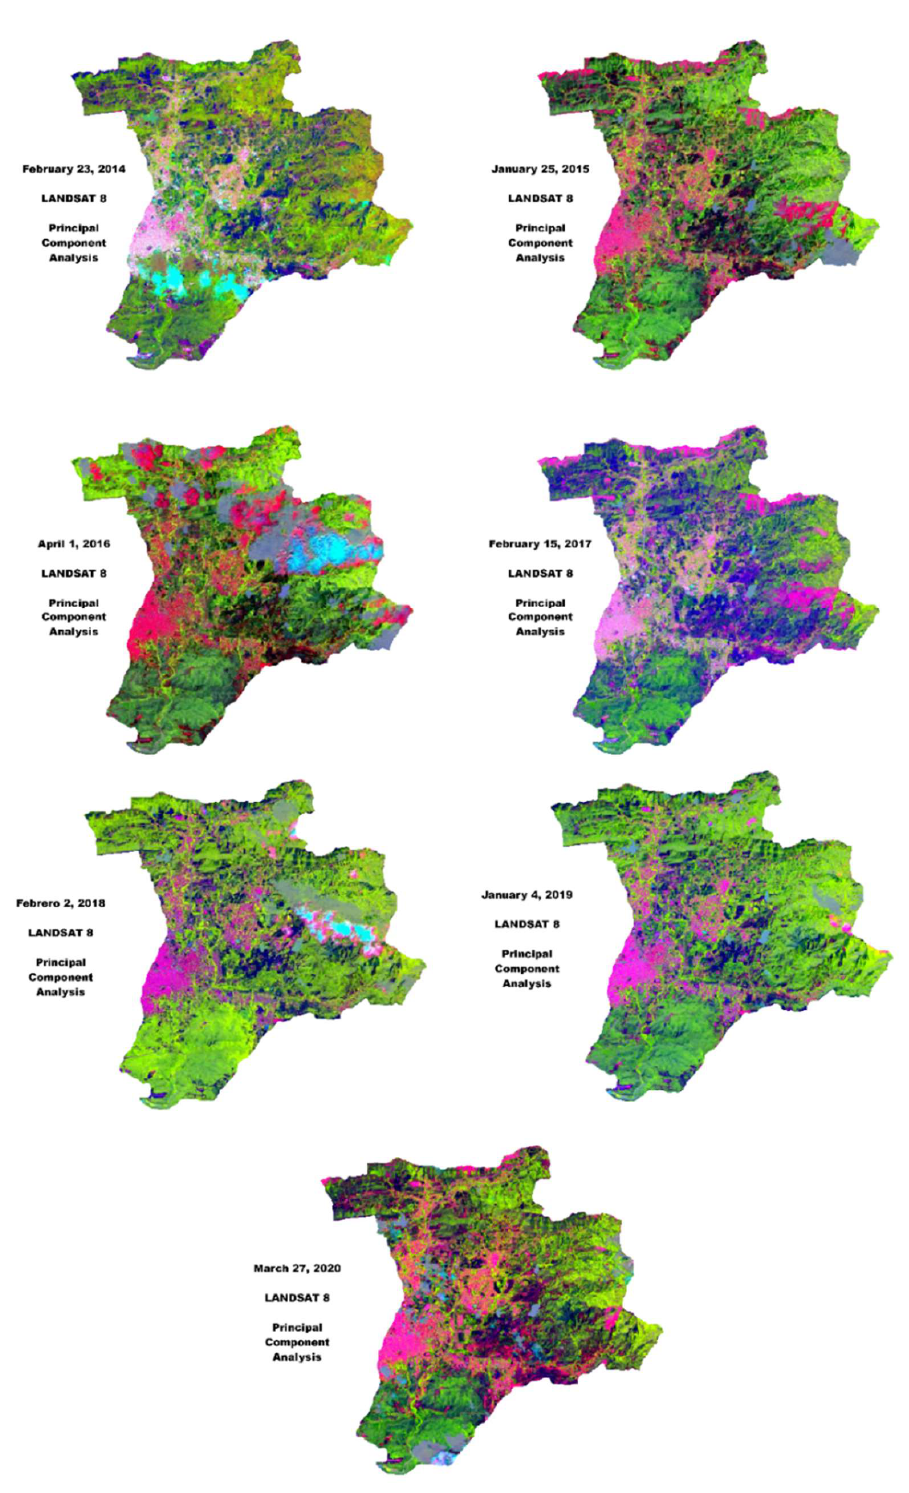
Figure A3. Analysis of the Main Components for the Projection of Areas Type “Without Forest Cover” (Caption: Color Green Represents Vegetation Remains while Coloring Magenta Urban Areas).